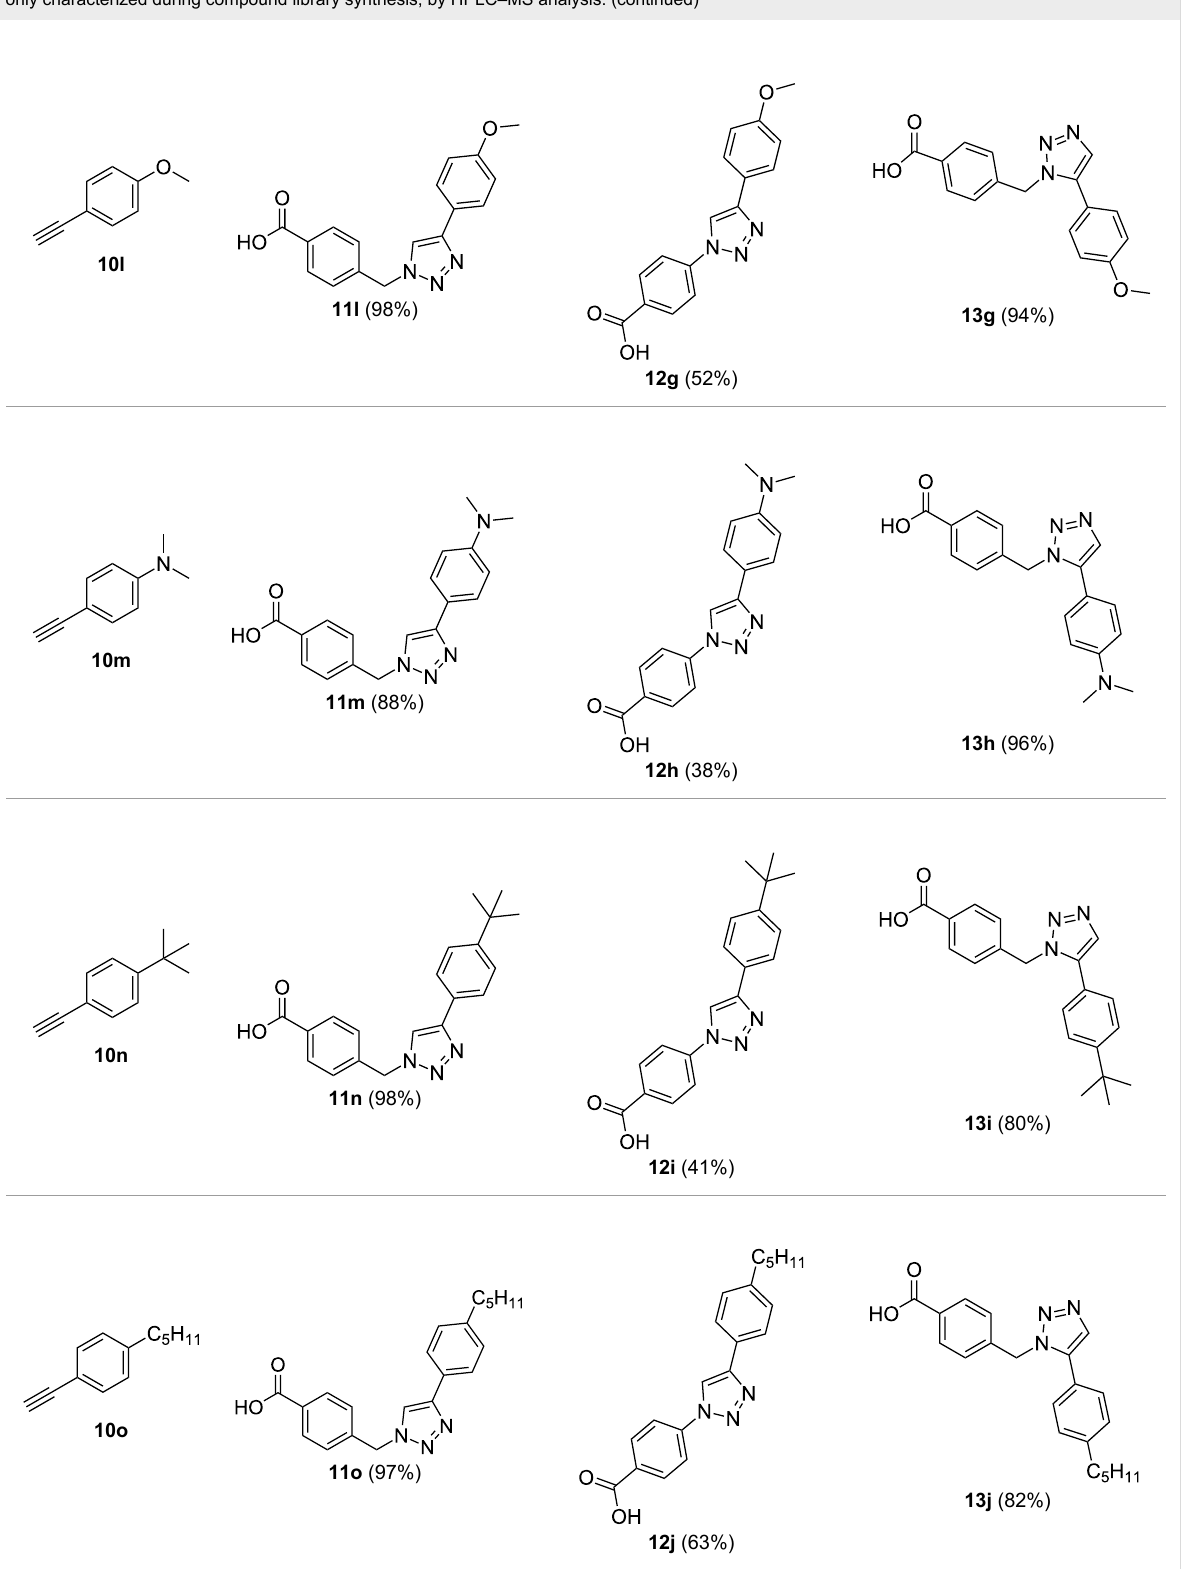
Table 2: Copper-catalyzed [2 + 3] cycloadditions of resin bound azide 7 with five terminal alkynes. Compounds 13 , with the exception of 13f , were only characterized during compound library synthesis, by HPLC–MS analysis.